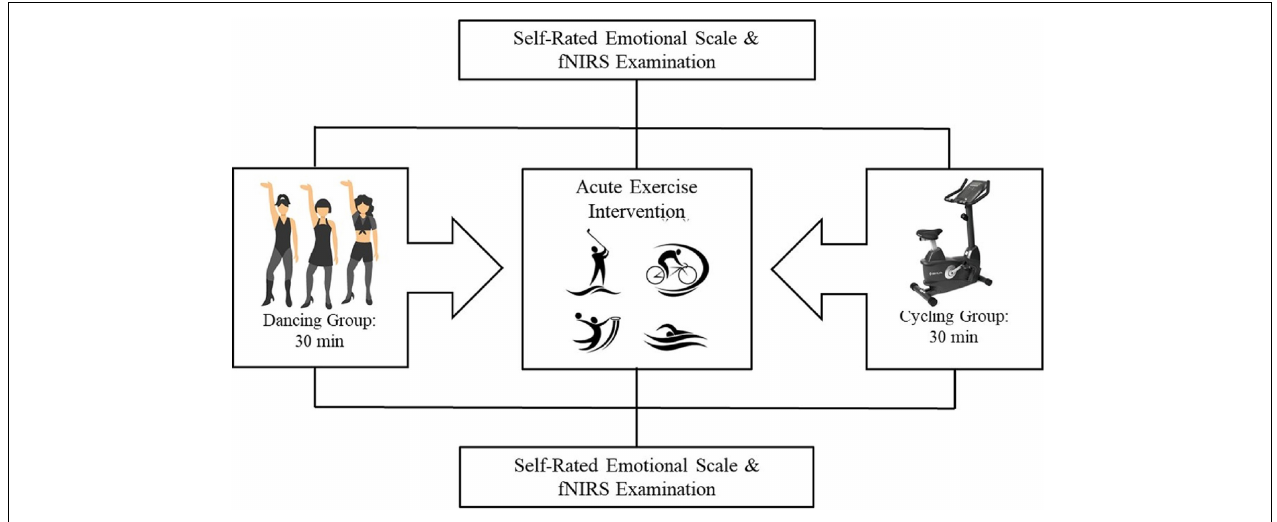
FIGURE 1 | Overview of the experimental